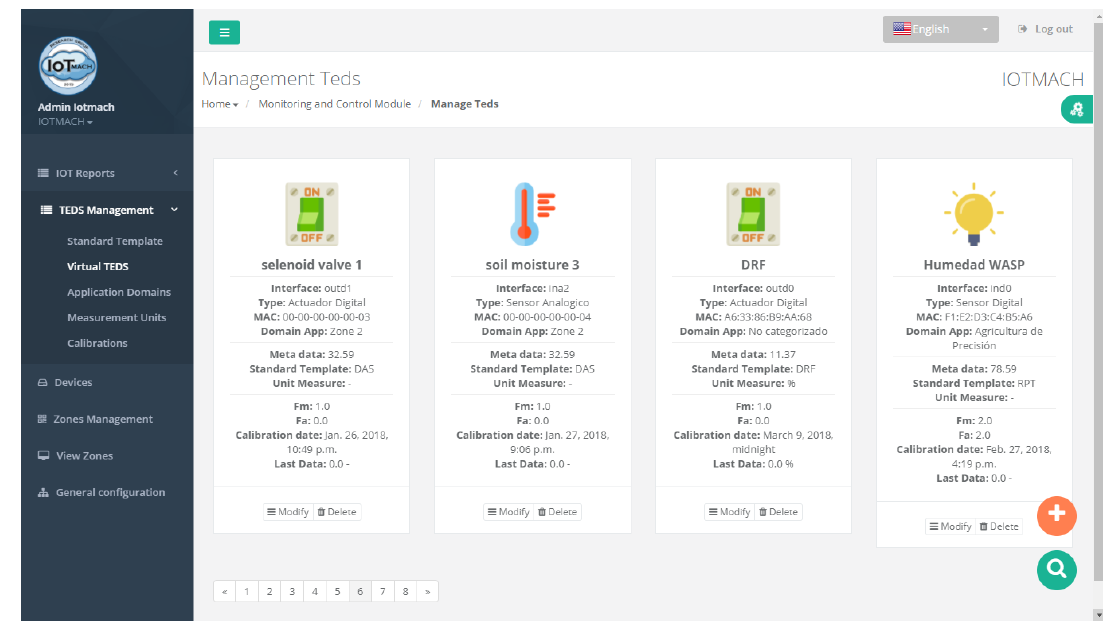
Figure 15. TED management application.